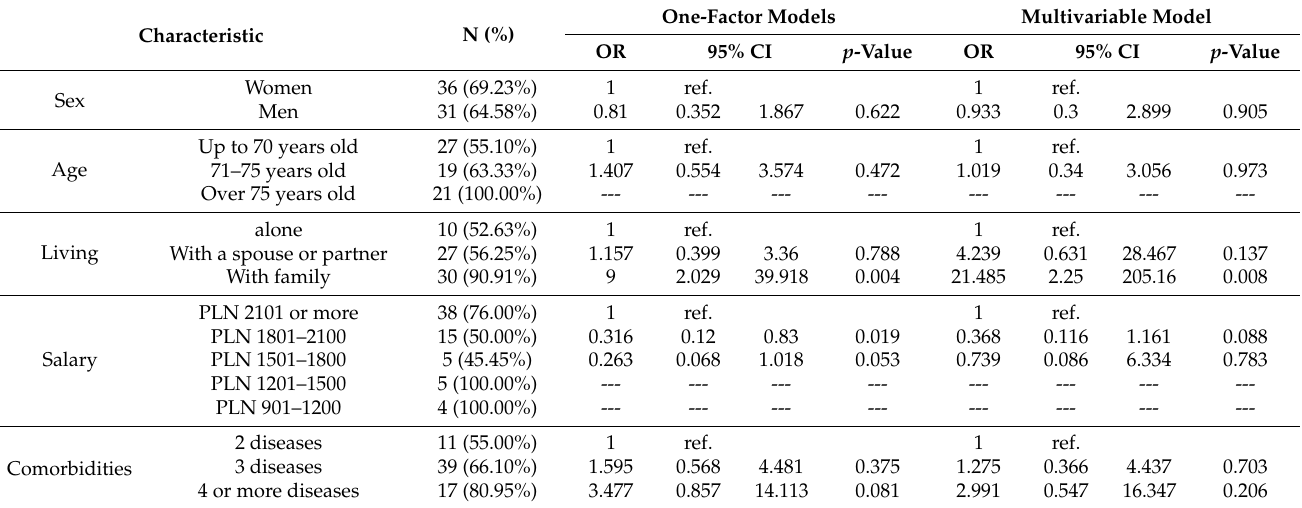
Table 6. Results of univariable and multivariable regression analysis—multimorbidity and